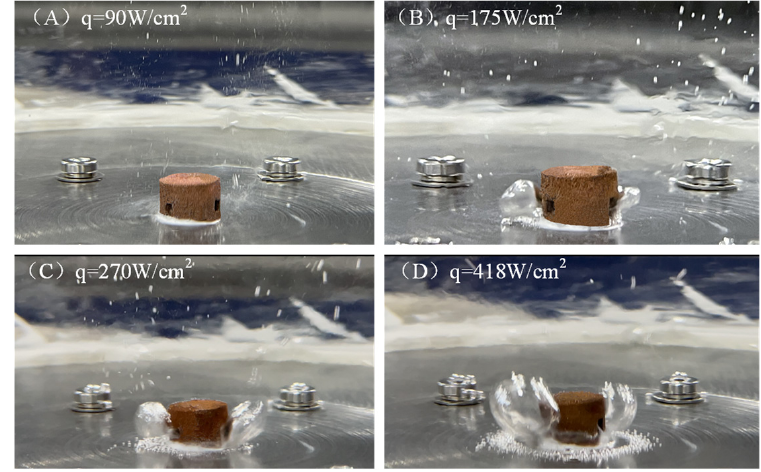
Figure 6. Liquid–vapor distribution and motion under different heat fluxes: ( A ) heat flux is 90 W/cm 2 ; ( B ) heat flux is 175 W/cm 2 ; ( C ) heat flux is 270 W/cm 2 ; ( D ) heat flux is 418 W/cm 2 .